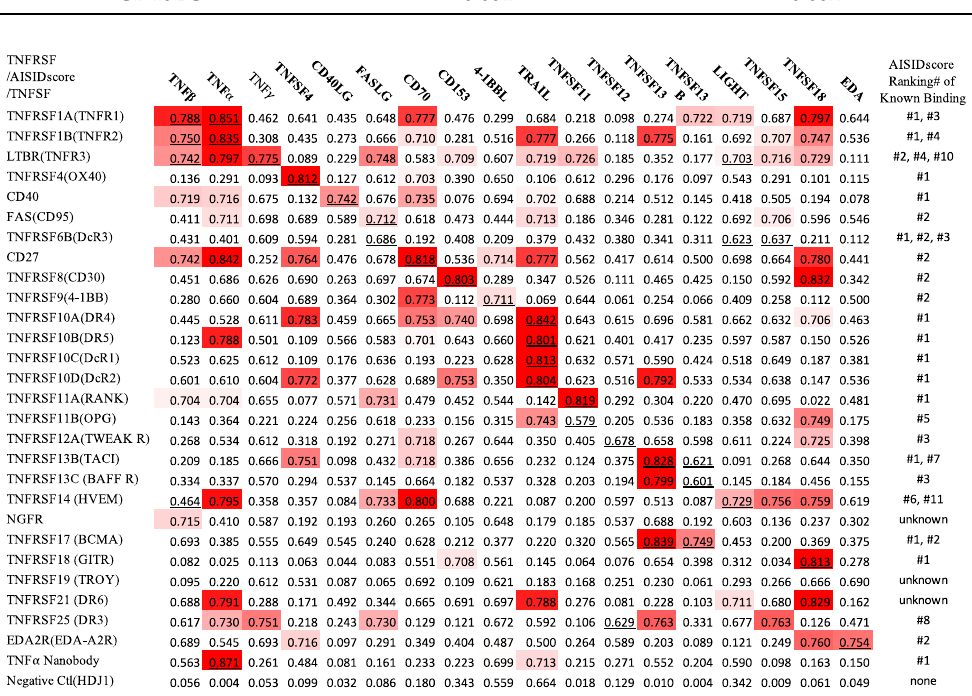
Figure 1. Heatmap of AISIDscores from 29 bait proteins (27 TNFRSF members, TNF α nanobody for positive control, Hsp40Hdj1 for negative control) against 18 TNFSF members. The AISIDscore of correct pairings between bait protein and TNFSF members are underlined. For each TNFRSF member, AISIDscores were ranked among 18 TNFSF members, with the ranking positions of the correct pairs are listed at the rightmost column. Three TNF receptor (NGFR, TROY, and DR6) do not have known ligands in TNFSF members and are labeled as “unknown”. The human Hsp40Hdj1 is labeled as “none”.